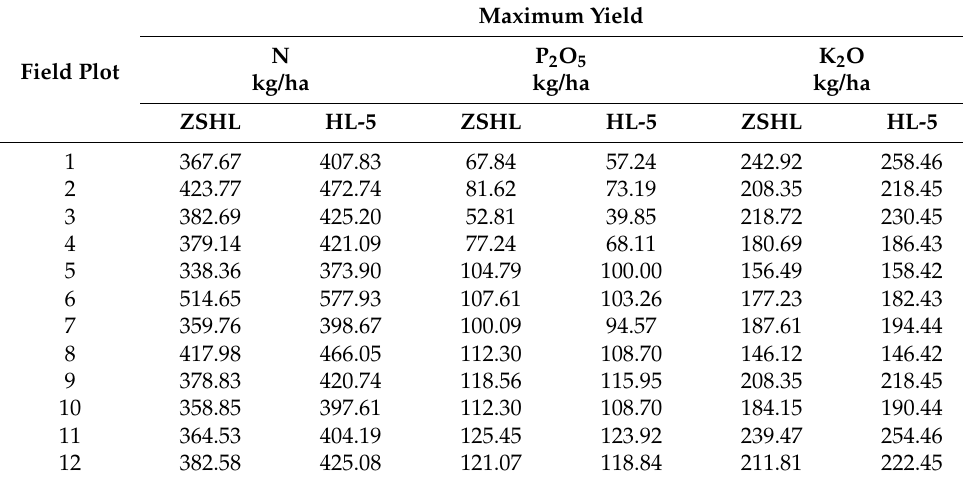
Table 3. The recommended amounts of N, P, and K fertilizers in different field plots.